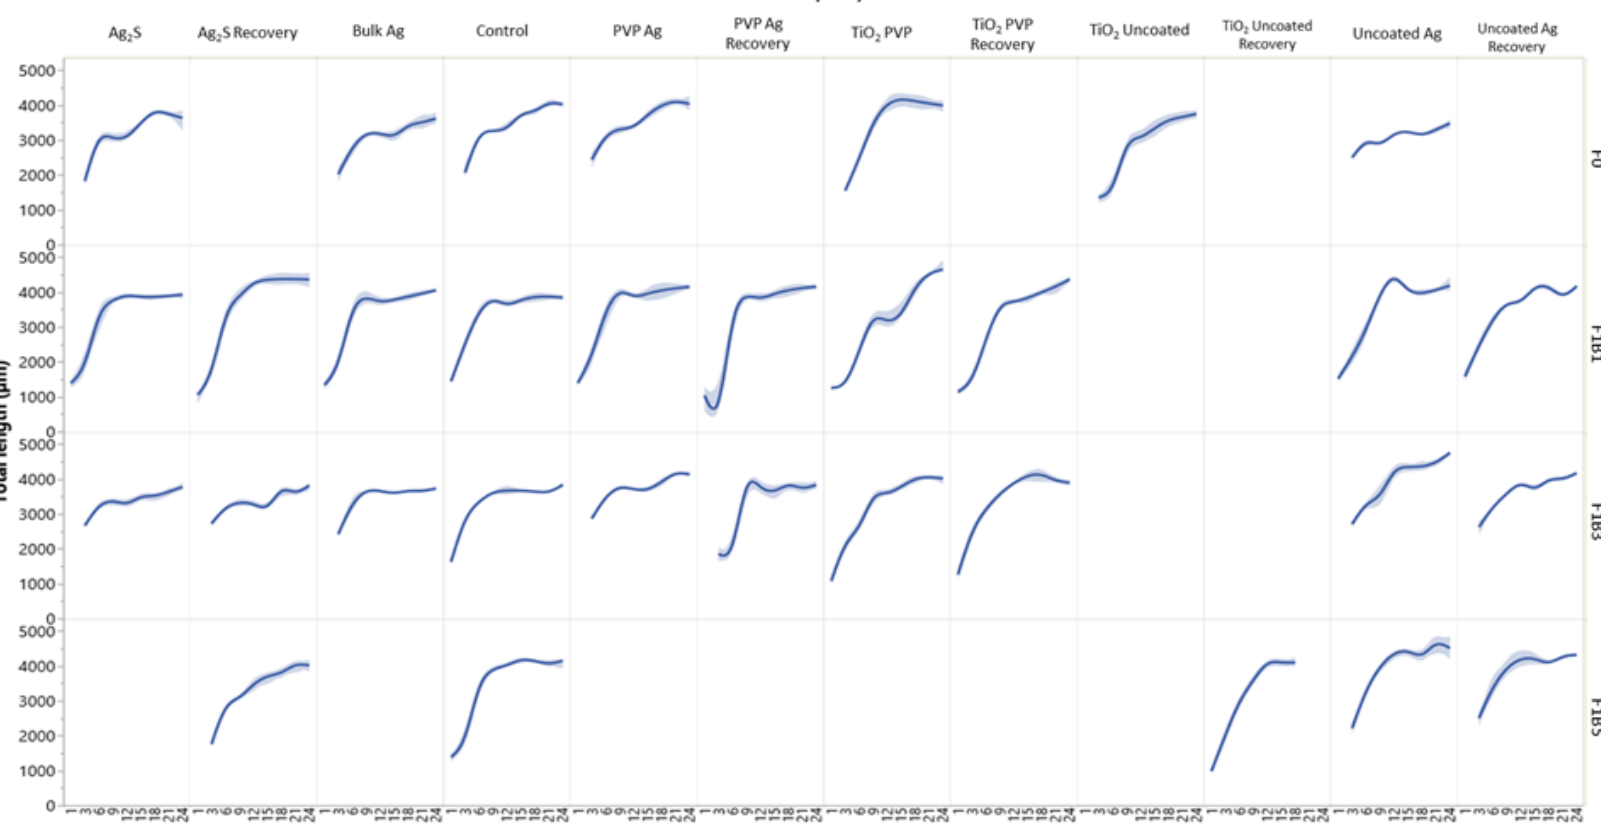
Figure 2. Size (measured as tail length) versus age for all F0 generations and broods F1B1, F1B3 and F1B5 of the subsequent F1 generations. Data are presented for daphnids continuously exposed to each of the Ag and TiO 2 NMs, and those in the recovery sets after removal from exposure. The y -axis indicates the average daphnid length (µm) (measuring from the apex of the helmet to the base of the tail) as a function of the daphnid age (days) on the X -axis. F0 = Parent exposure to the particular NM is noted at the top of the plots. The graph splits horizontally by each of the generations and vertically by the NM exposure condition. The shaded areas around the lines are the 95% confidence bands. N = 5.